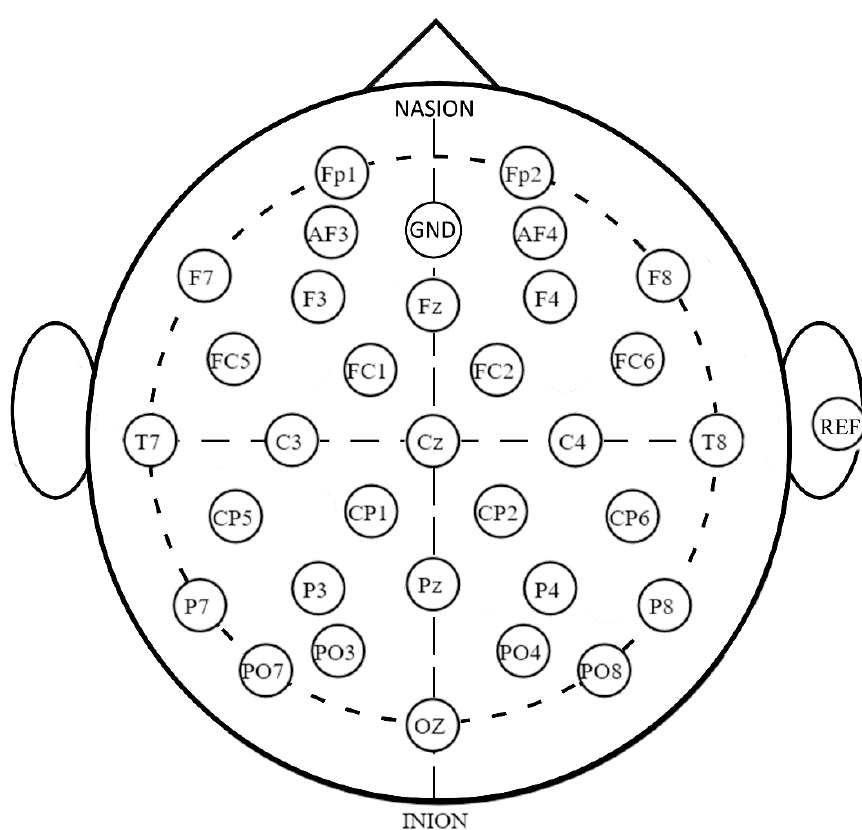
Figure 2. The montage for g.Nautilus electroencephalography (EEG) 32 channel acquisition system, GND is the ground channel, REF is the reference channel.